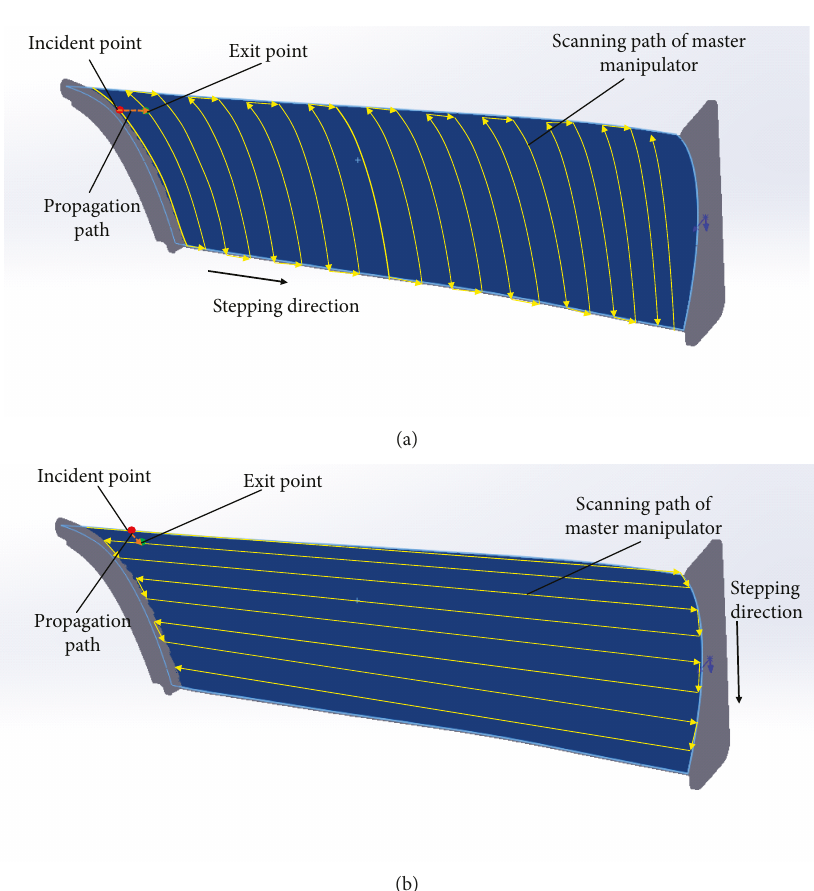
Figure 5: Di ff erent zig-zag scan modes for surface